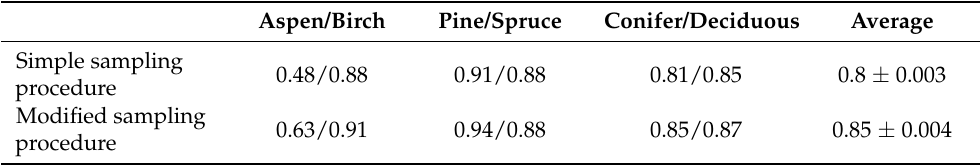
Table 3. Forest types classification using different sampling procedure (per-pixel F1-score).